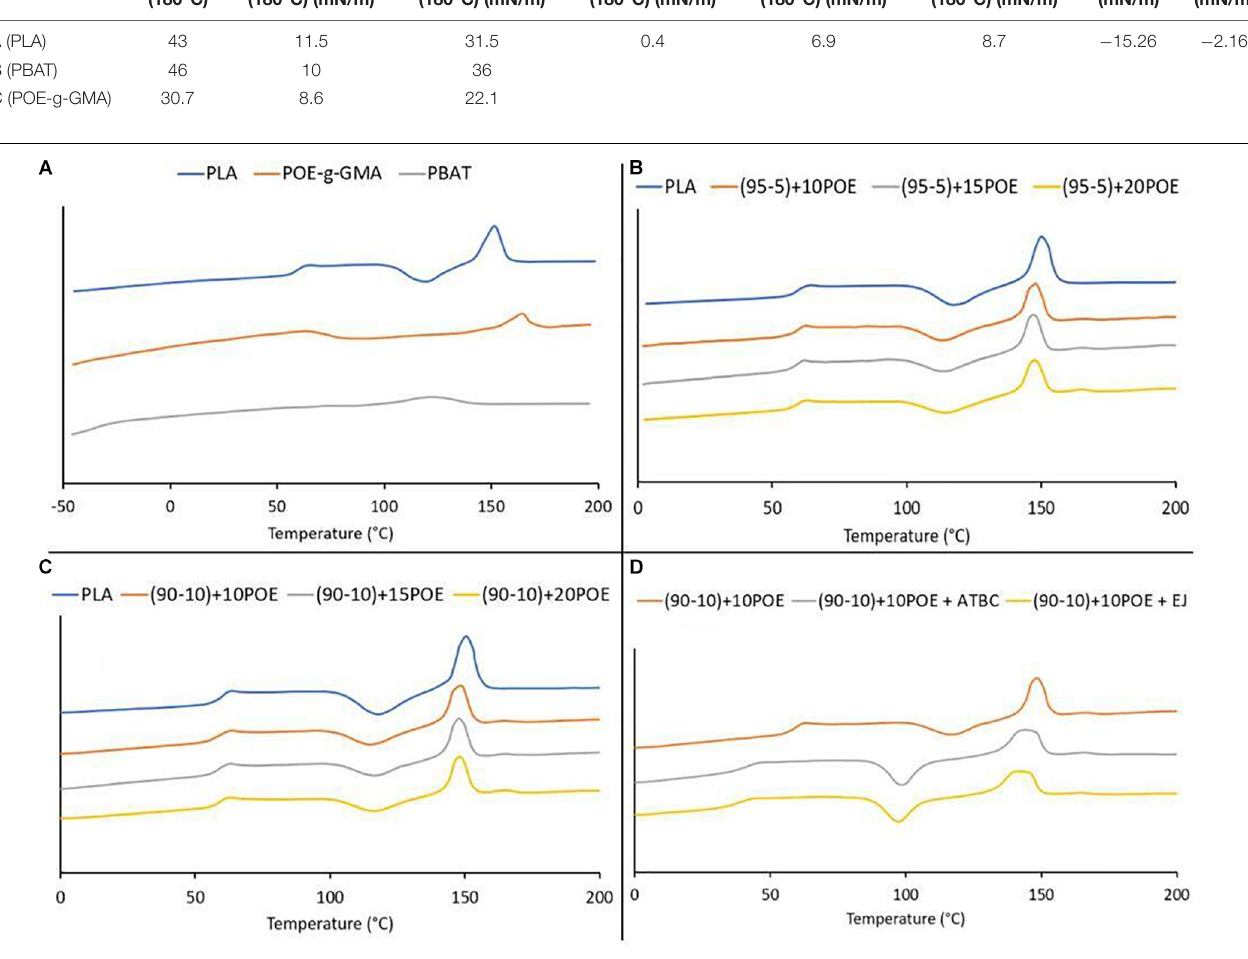
FIGURE 4 | DSC thermograms for: (A) pure materials; (B) (95-5) based ternary blends; (C) (90-10) based ternary blends; (D) plasticized ternary